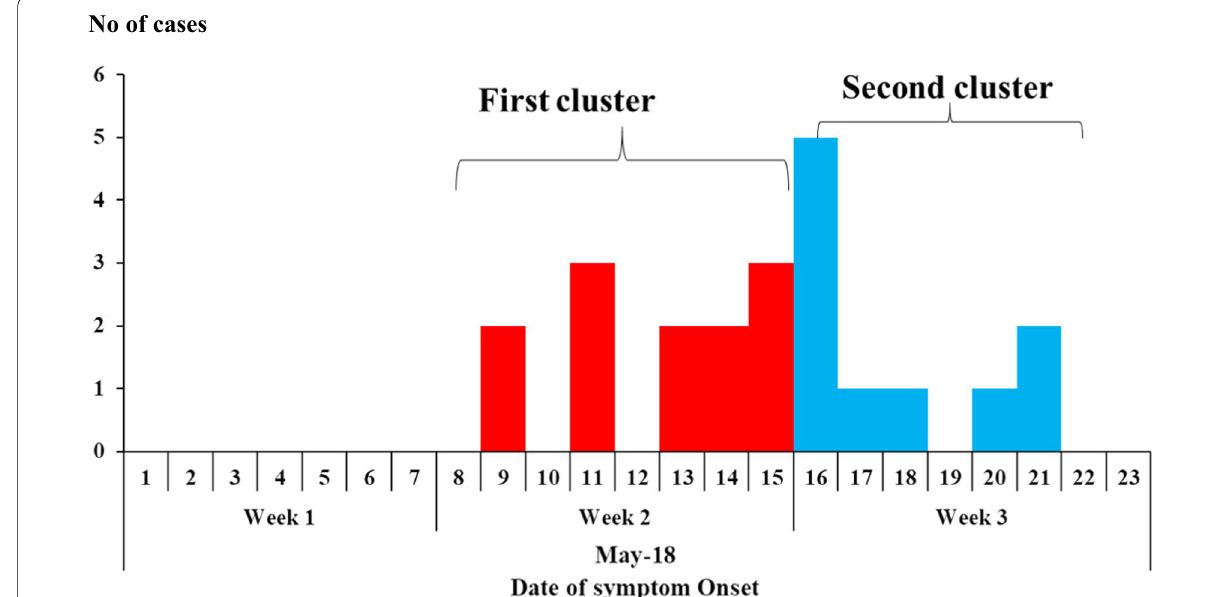
Fig. 3 Overall epidemic curve showing the distribution of case‑persons over time and points of exposure during the anthrax outbreak in